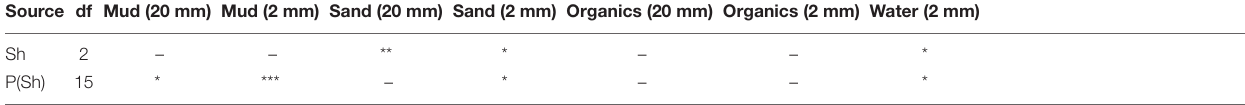
2 samples from each of n = 6 replicate plots. Asterisks indicate significance, *p < 0.05, **p < 0.01, ***p < 0.001.